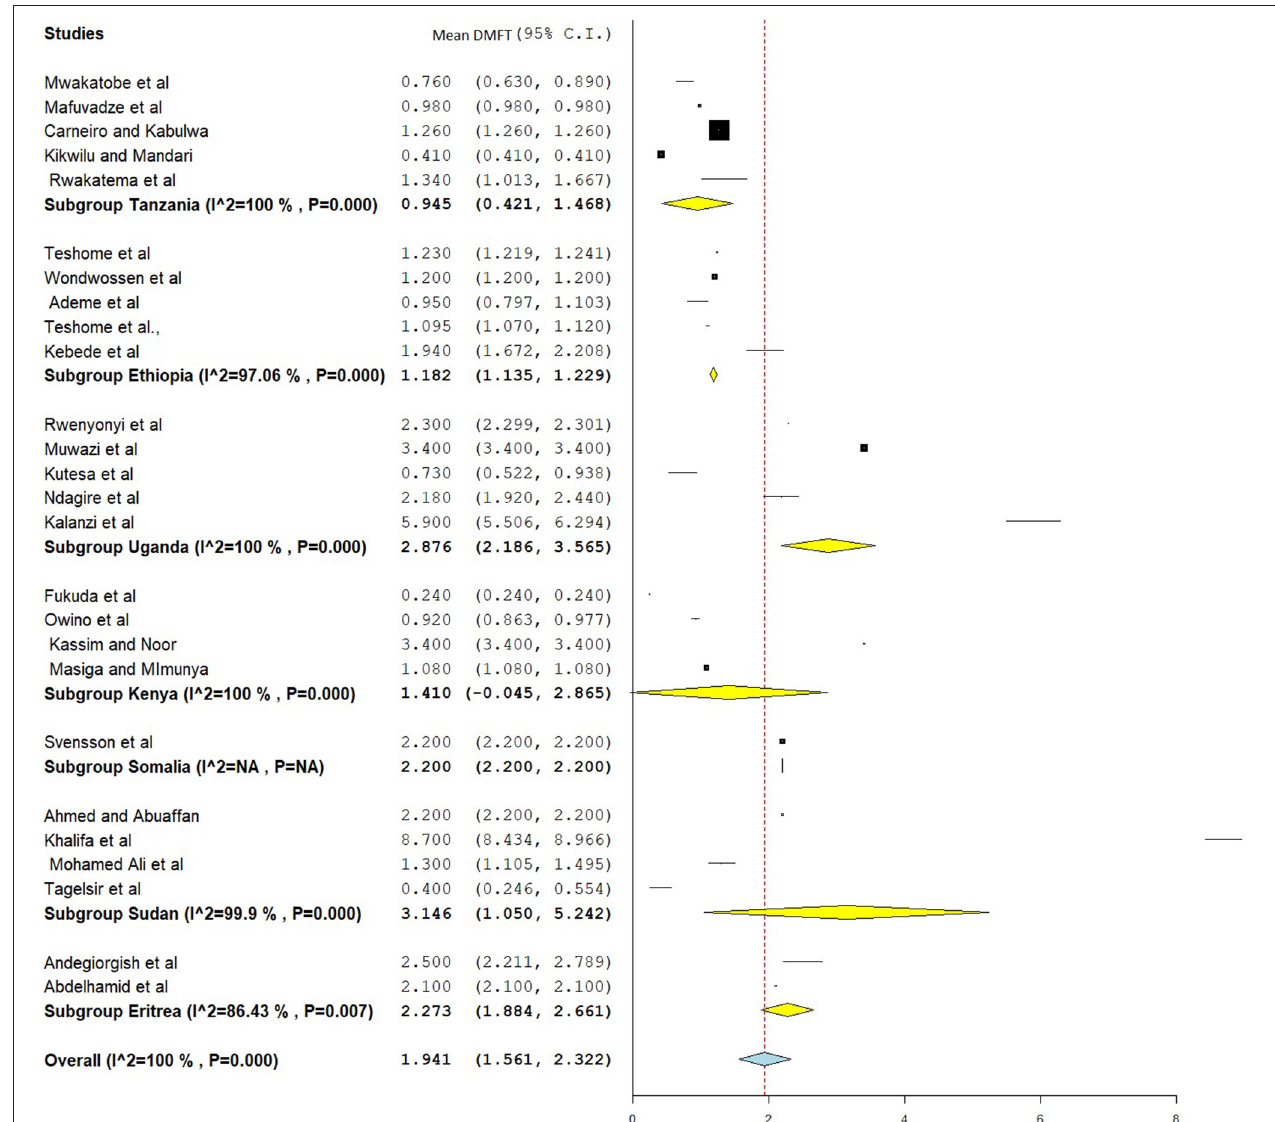
FIGURE 8 | Subgroup analysis on mean DMFT based on